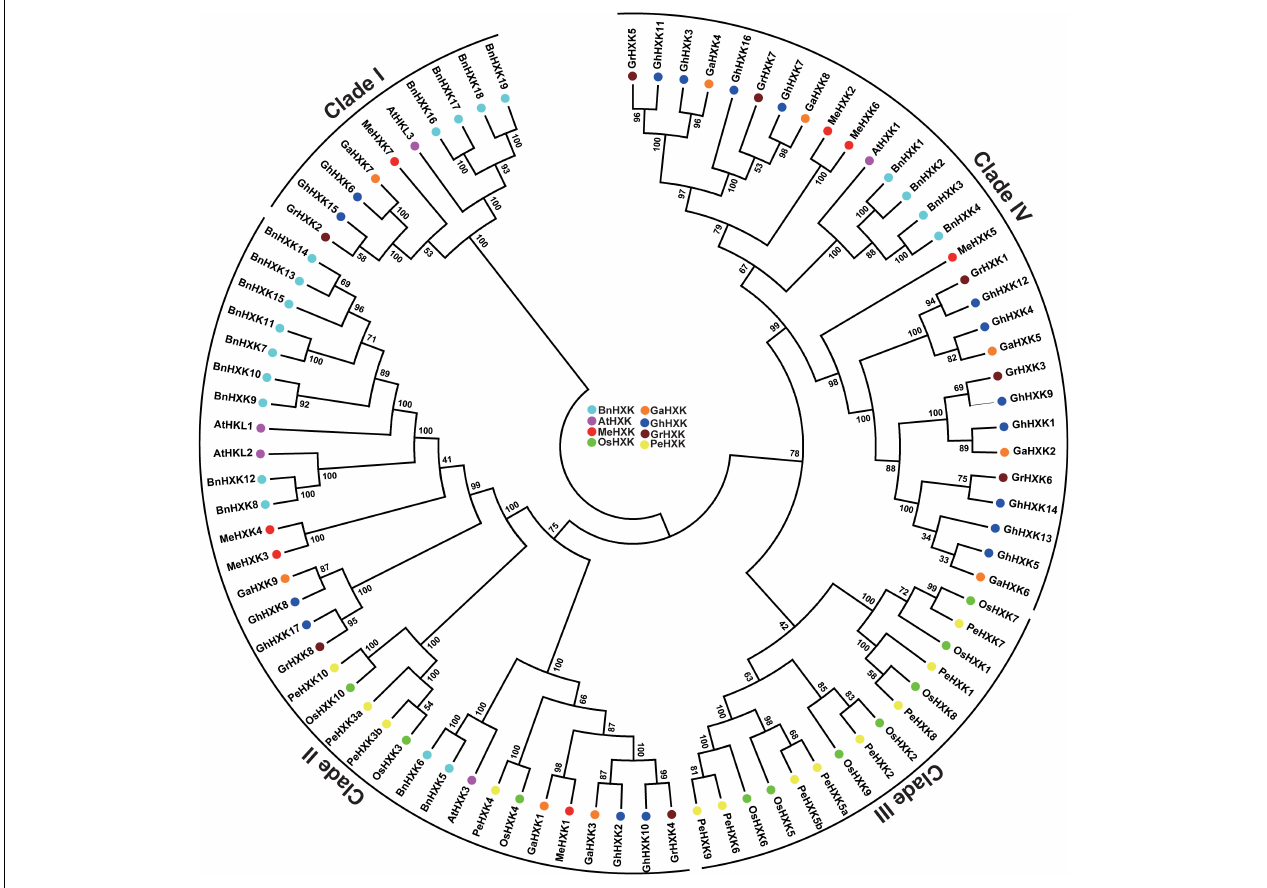
FIGURE 4 | Phylogenetic analysis of GhHXK proteins in G. hirsutum L. An unrooted phylogenetic tree was constructed using HXK protein sequences from A. thaliana (AtHXK), O. sativa (OsHXK) , P. edulis (PeHXK), M. esculenta (MeHXK), B. napus (BnHXK), G. hirsutum L. (GhHXK), G. raimondii (GrHXK), and G. arboreum (GaHXK), and are displayed in purple, green, yellow, red, light blue, dark blue, dark red, and orange,